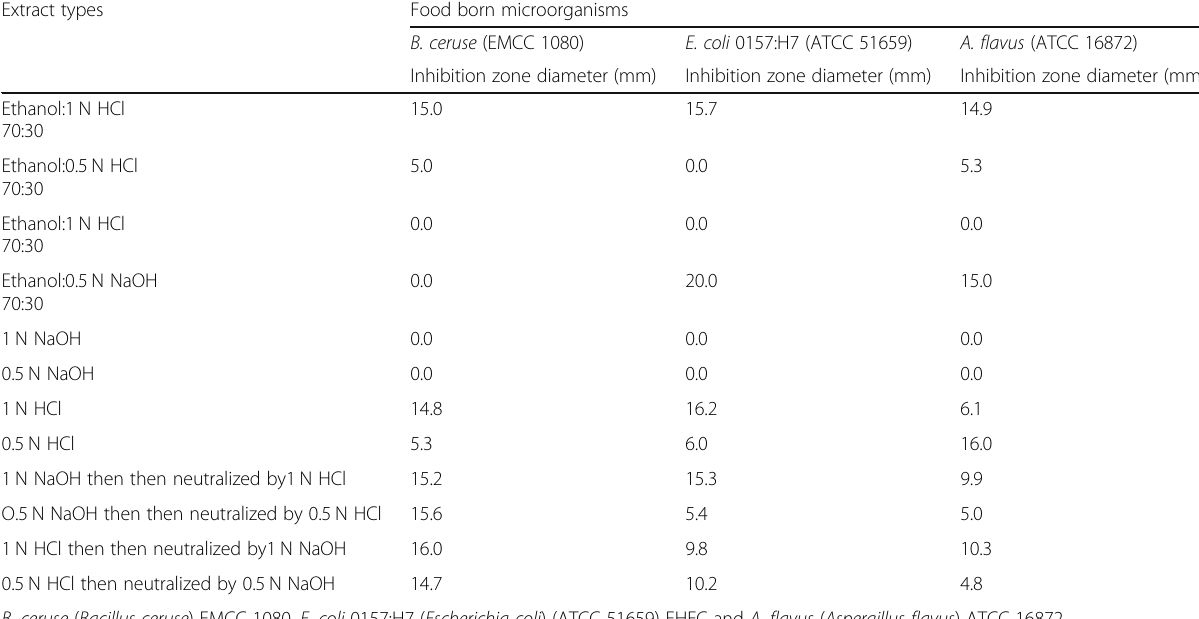
Table 6 Antimicrobial effect of jatropha hull extract on the inhibition growth of food born microorganisms Extract